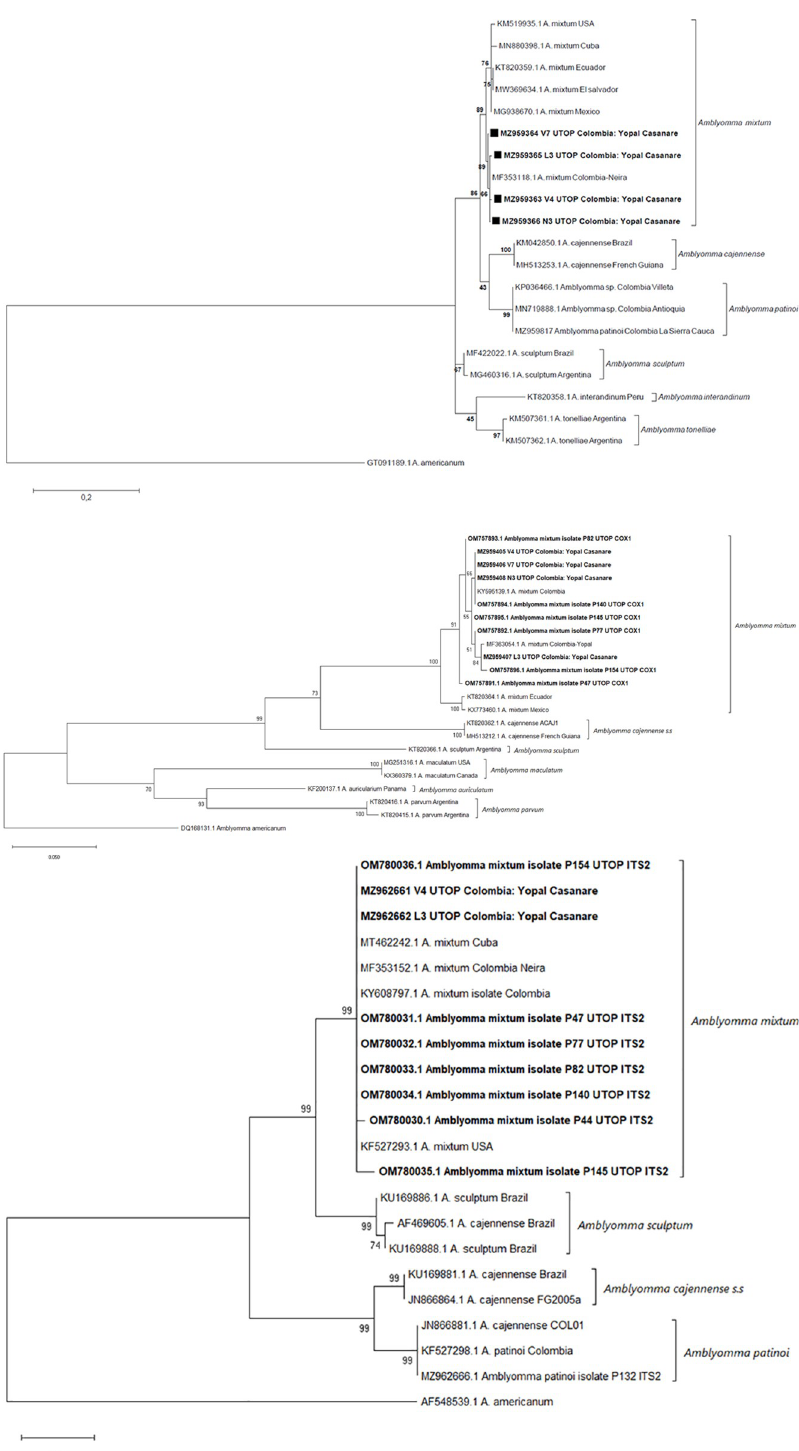
Fig 3. Phylogenetic trees for the 16S rRNA and COI mitochondrial genes and the ITS-2 nuclear gene of A . mixtum . Phylogenetic analysis using (A) the large subunit ribosomal RNA (16S-rRNA) gene sequences, (B) the Cytochrome C Oxidase subunit I (COX-1) gene sequences, and (C) the Internal Transcribed Spacer 2 (ITS-2) gene sequences of Amblyomma mixtum tick specimens collected in our study (in bold) and A . mixtum sequences from GenBank. Numbers at nodes are bootstrap support values. The correspondant gene sequence of Amblyomma americanum was used as the